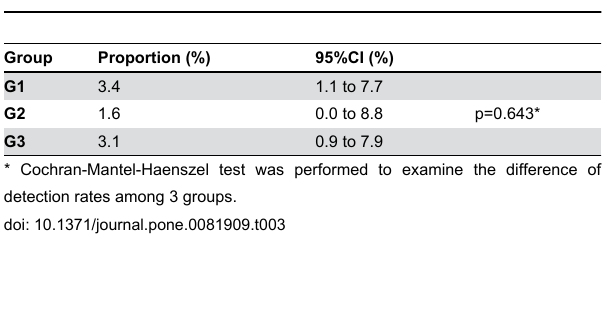
Table 3. Proportion of residents with internal radiation exposure of Cs-137 above the detection limit by population group.